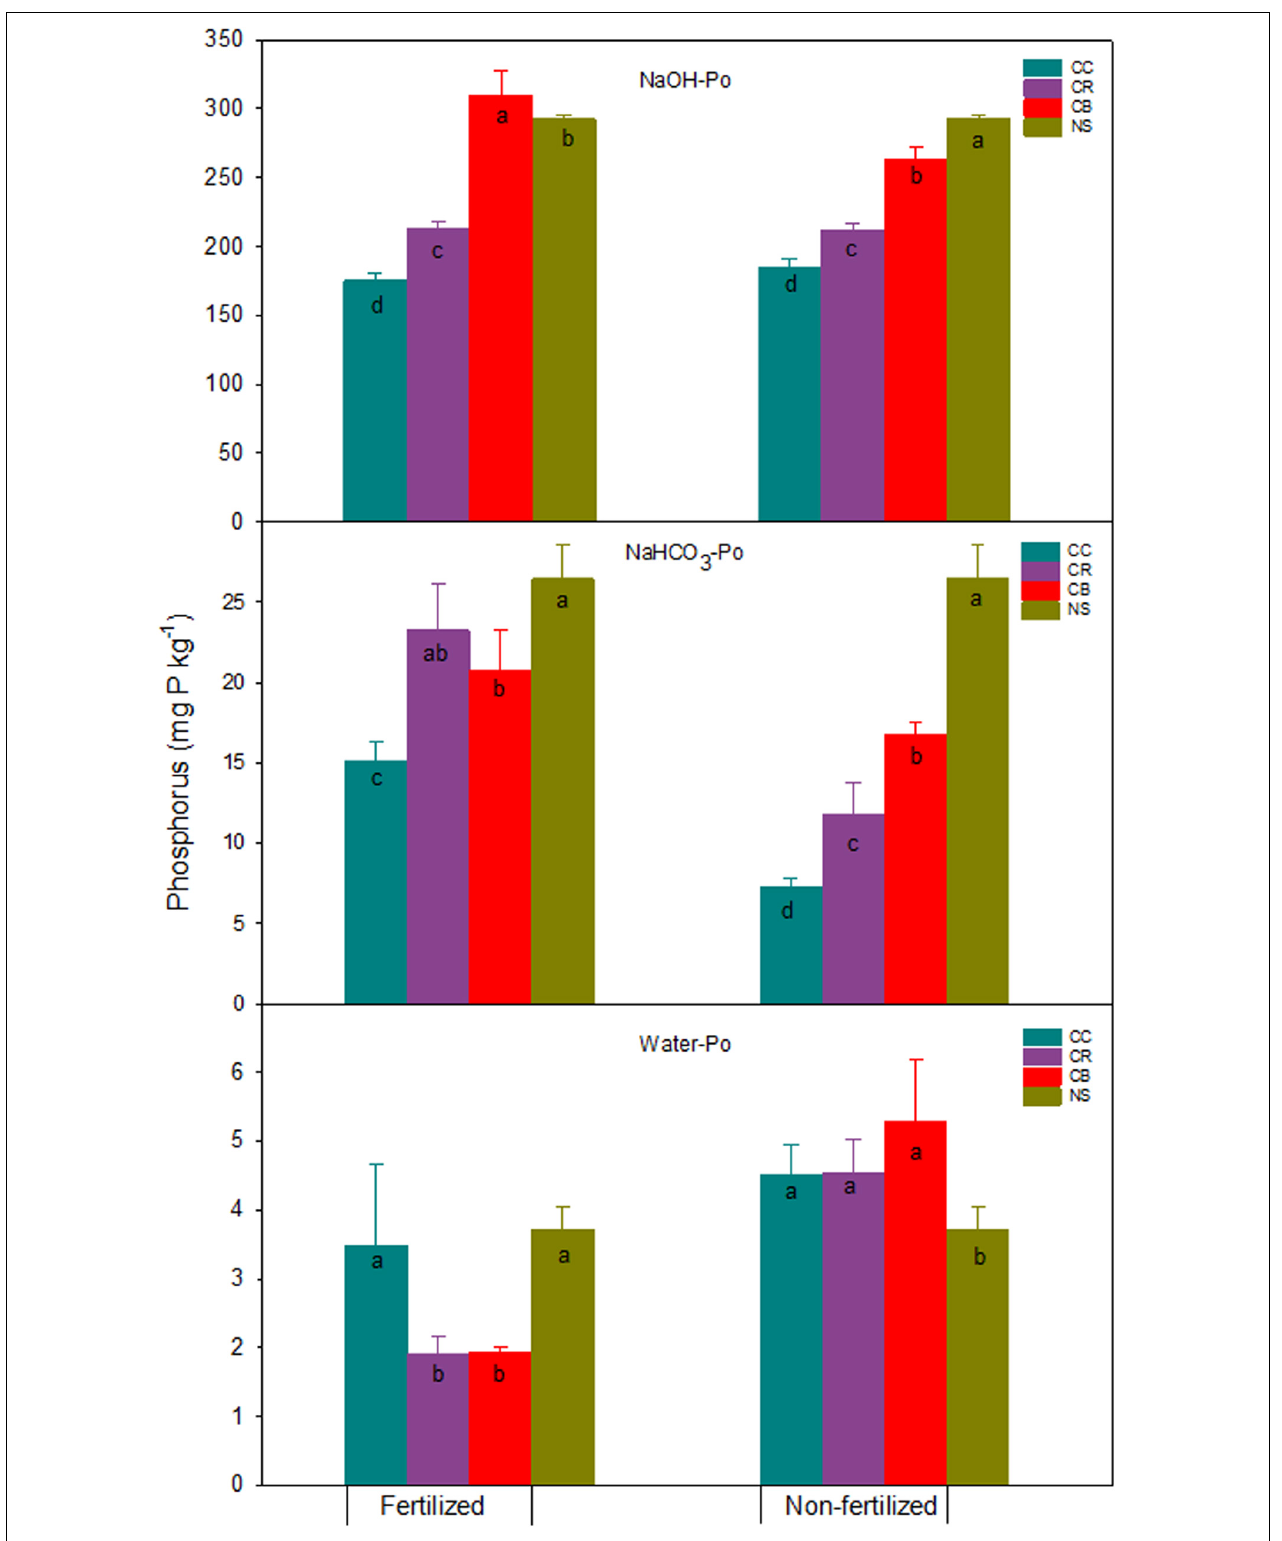
FIGURE 4 | Water-P o , NaHCO 3 -P o , NaOH-P o , and standard errors ( n = 3) (mg kg − 1 ) in a Brookston clay loam at Woodslee, ON, Canada, after 45-year consistent cropping with and without P fertilization relative to its native forest soil (NS). CC, continuous corn; CB, continuous bluegrass sod; CR, corn-oats-alfalfa-alfalfa rotation. Letters in the bars are significant levels (at P ≤ 0.05) with LSD test conducted separately for the fertilized and non-fertilized treatments.